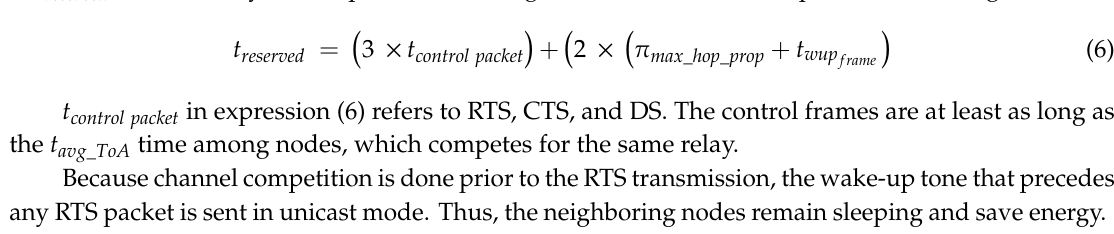
Algorithm 1. Tone-competition internal algorithm for senders.